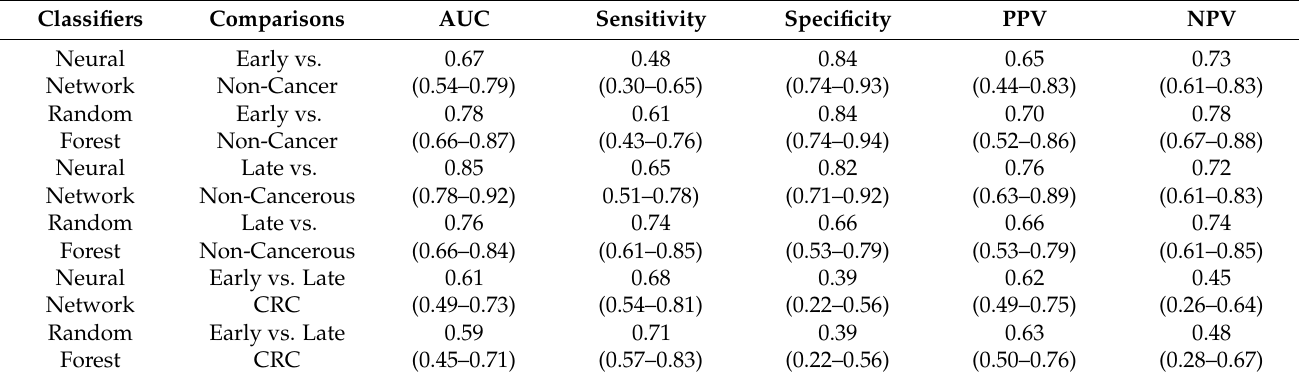
Table 6. Statistical Results for CRC stage comparisons with 95% confidence intervals in brackets using